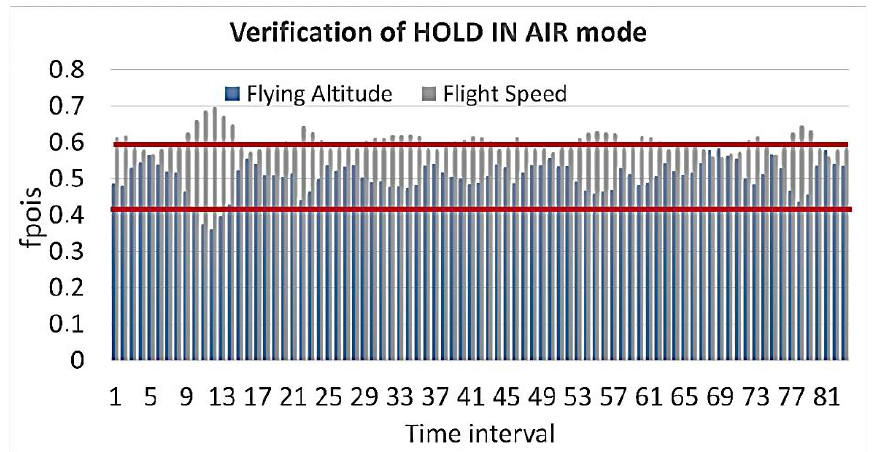
Figure 7. Verification of the HOLD IN AIR mode calculation of the cumulative function for the Poisson distribution during an attack.